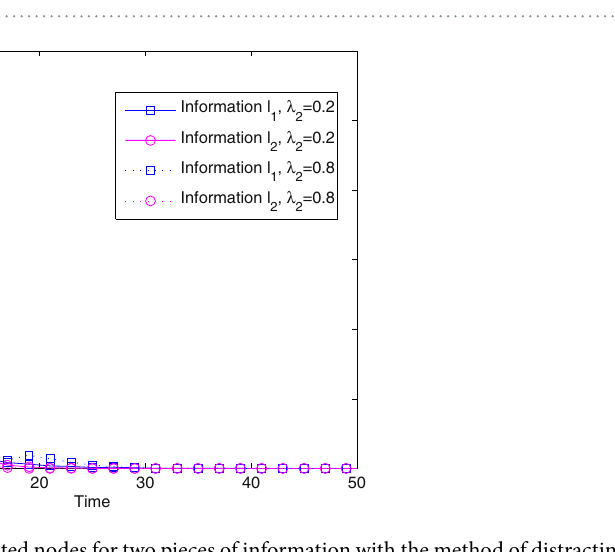
from that for l 2 , meaning the impact is not significant. When λ 2 is large, the peak for l 2 is greatly enhanced. It is dramatic that the density of infected nodes for l 1 has two peaks. When the density of spreaders for l 2 drops to a low level, more infected nodes for l 1 occur and their density increases. Therefore, the restraining action plays a role in the initial phase of diffusion. When information l 2 stops propagating, the diffusion of l 1 is recovered. However, the maximal density for l 1 declines severely, implying that a strong restraining effect has occurred. In addition, the method of distracting node attention accelerates the diffusion process. Within less than 30 time steps, all infected nodes become refractory, leading to a short relaxation time of the system. Figure 8 shows the final density of refractory nodes for information l 1 under different actions of l 2 . When information l 2 propagates at the beginning, the spreading threshold of l 1 is changed. For T = 0, larger spreading